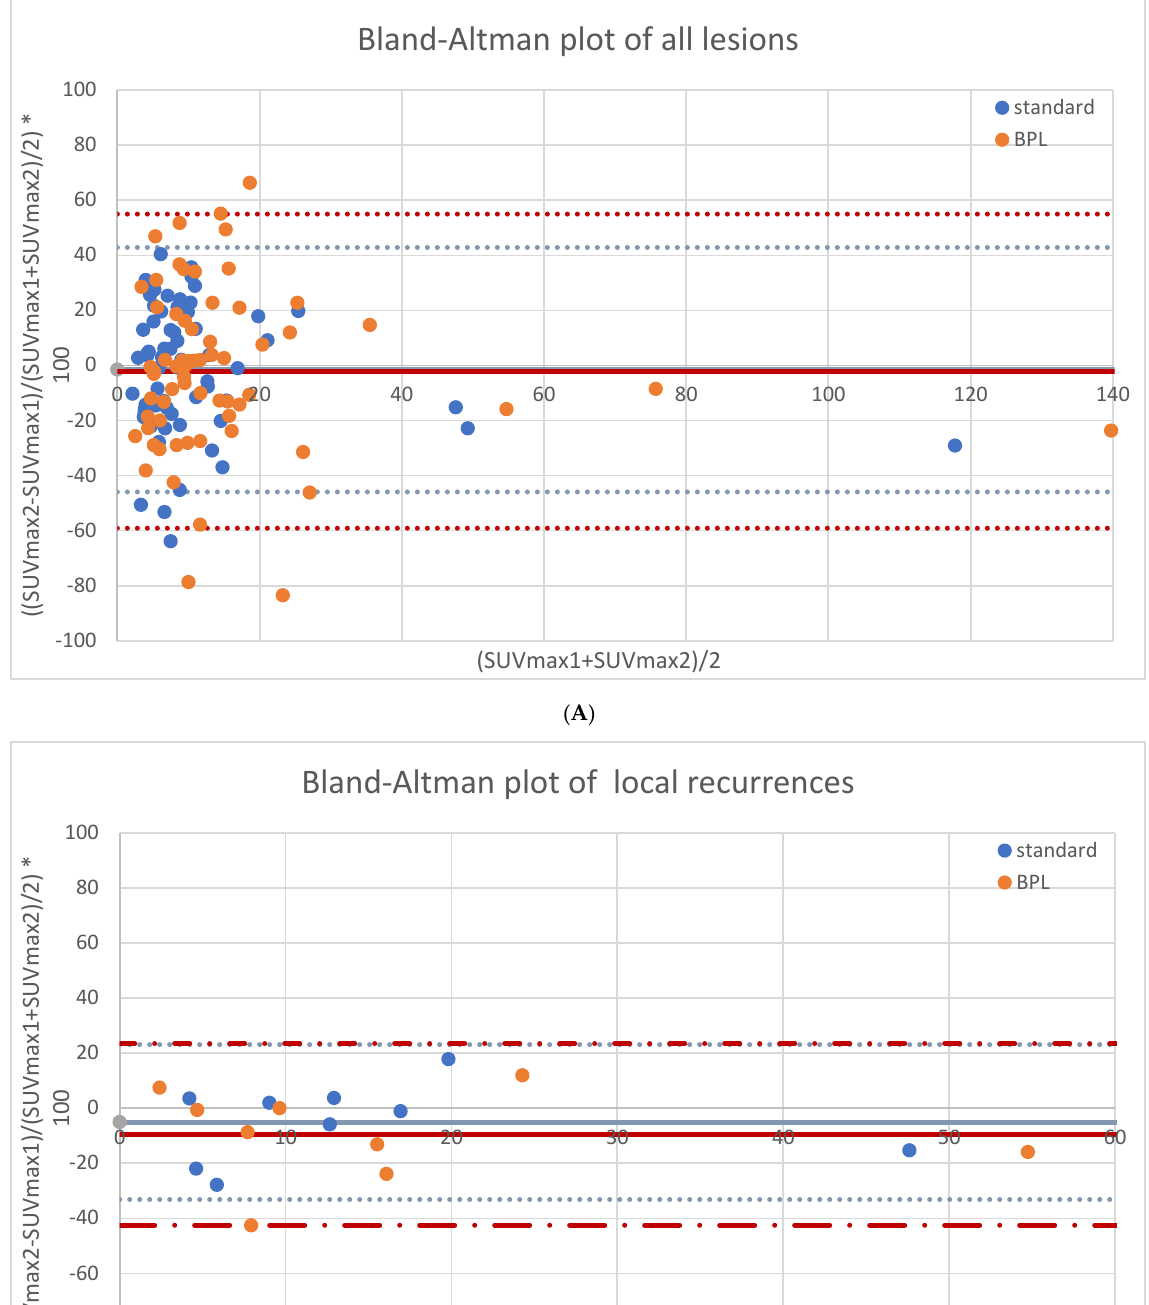
+56.6% and −63.2%. See Figure 1C. For suspected bone metastases, SUVmax had a repeat- ability of +4.4% ± 26.1%, with upper and lower limits of agreement of +55.7% and −46.8% for standard OSEM reconstructions. For BPL reconstructions, SUVmax repeatability was +2.7% ± 32.8%, with upper and lower limits at +67.0% and −61.6%. See Figure 1D. None of Figure 1D. None of the differences between standard OSEM and BPL reconstructions were the differences between standard OSEM and BPL reconstructions were statistically signif- statistically significant. icant.